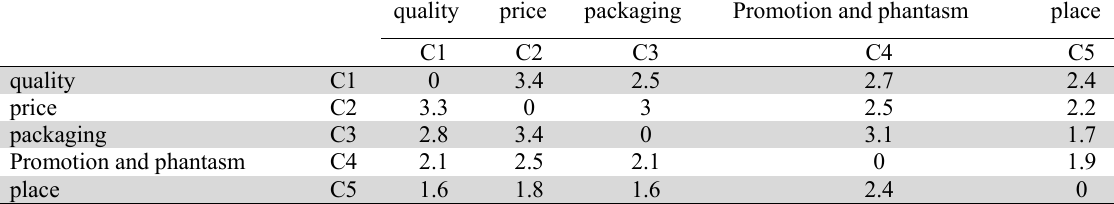
The initial direct relation matrix, which is obtained by averaging the answer matrices quality